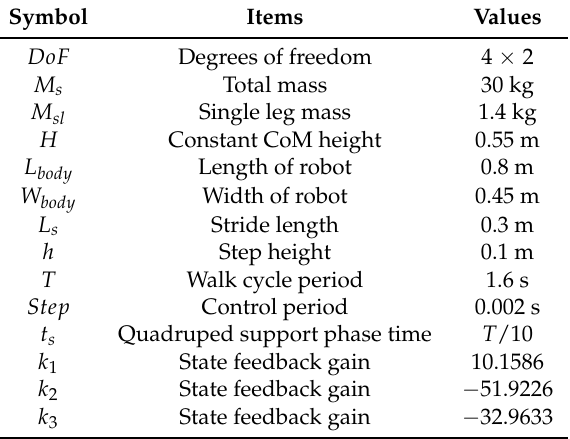
Table 1. Parameters for simulation and